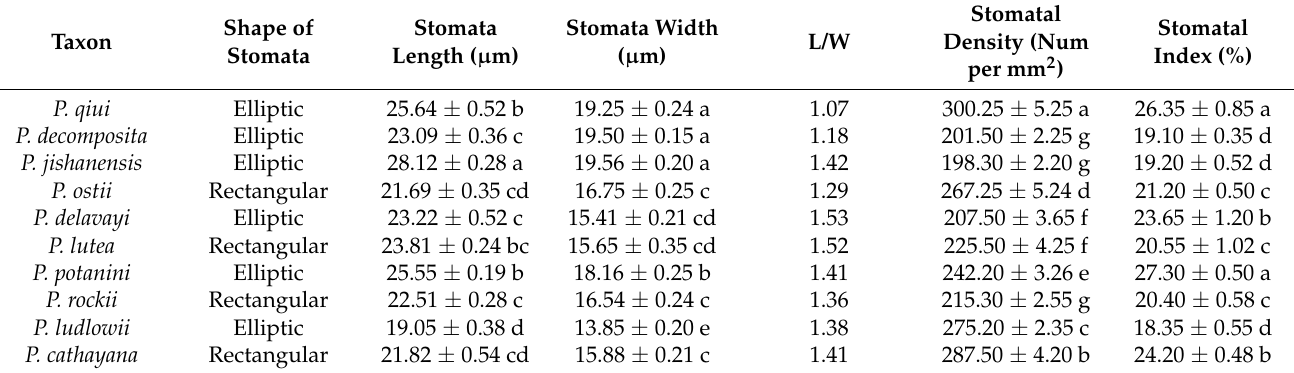
Table 3. Characteristics of stomatal